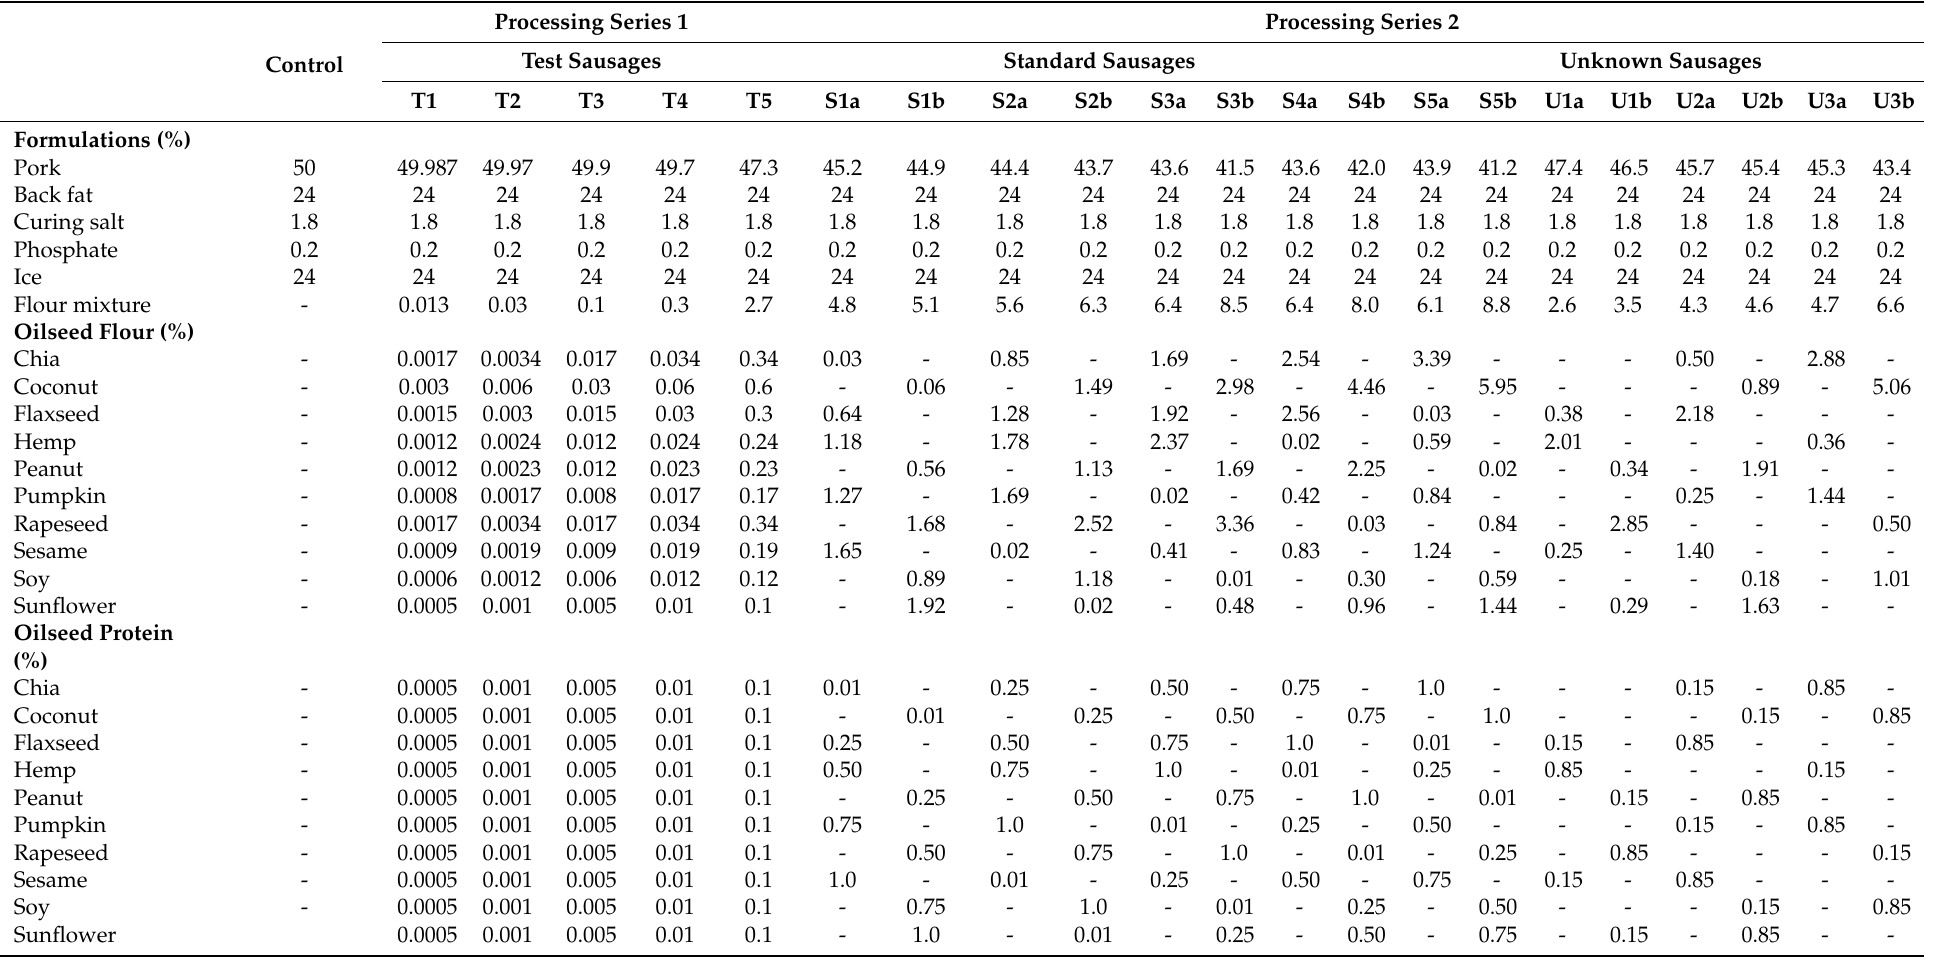
Table 1. Batches and formulations of sausages with different concentrations of oilseed flours for processing series 1 (test sausages T1–T5: 0.0005, 0.001, 0.005, 0.01